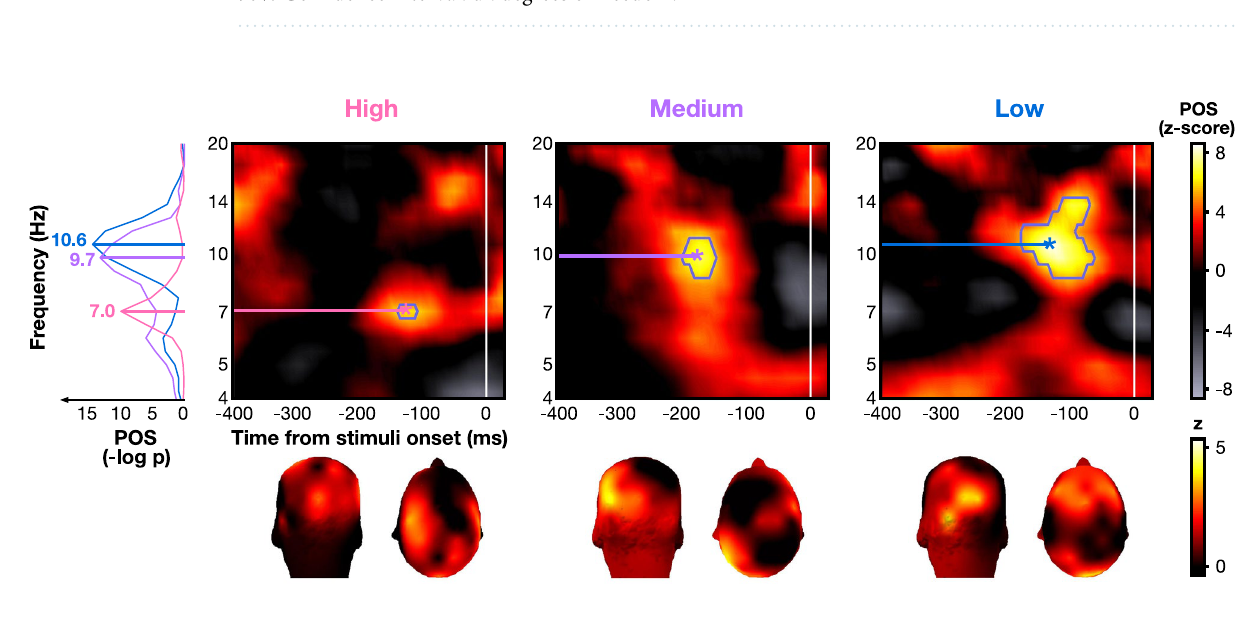
Figure 2. Pre-stimulus phase opposition between correct and incorrect trials in Experiment 1. Z-score of pre-stimulus phase opposition sum (POS) of correct and incorrect trials for the high, medium and low discriminability conditions, combined across all electrodes and all participants. Blue contours indicate areas above the FDR threshold (alpha = 10 –7 , corresponding to p value thresholds of 2.2e−10, 5.0e−10, and 4.7e−9 respectively). Stars indicate the time–frequency point of maximum significance (high: z max = 6.42 at f max = 6.96 Hz and t max = − 129 ms; medium: z max = 7.49 at f max = 9.75 Hz and t max = − 176 ms; low: z max = 8.91 at f max = 10.60 Hz and t max = − 137 ms). Topomaps represent the average POS (z-score) at each electrode across participants for the point of maximum significance, indicated by a star. The left panel plot shows the converted POS (−log p values) of the high, medium and low discriminability conditions (pink, purple and blue traces, respectively) at the timepoint with the maximum z-score (bootstrap-corrected POS in −log(p) of 10.17 for high, 13.48 for medium and 14.68 for